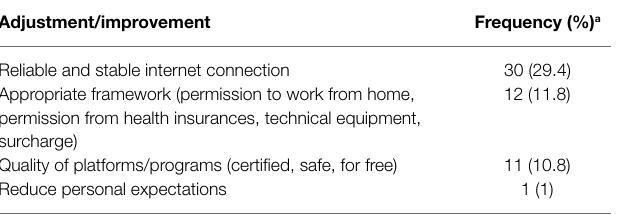
a Relative numbers refer to all returned eEMDR session protocols (N = 102). Qualitative statements were reviewed and combined to superior categories.